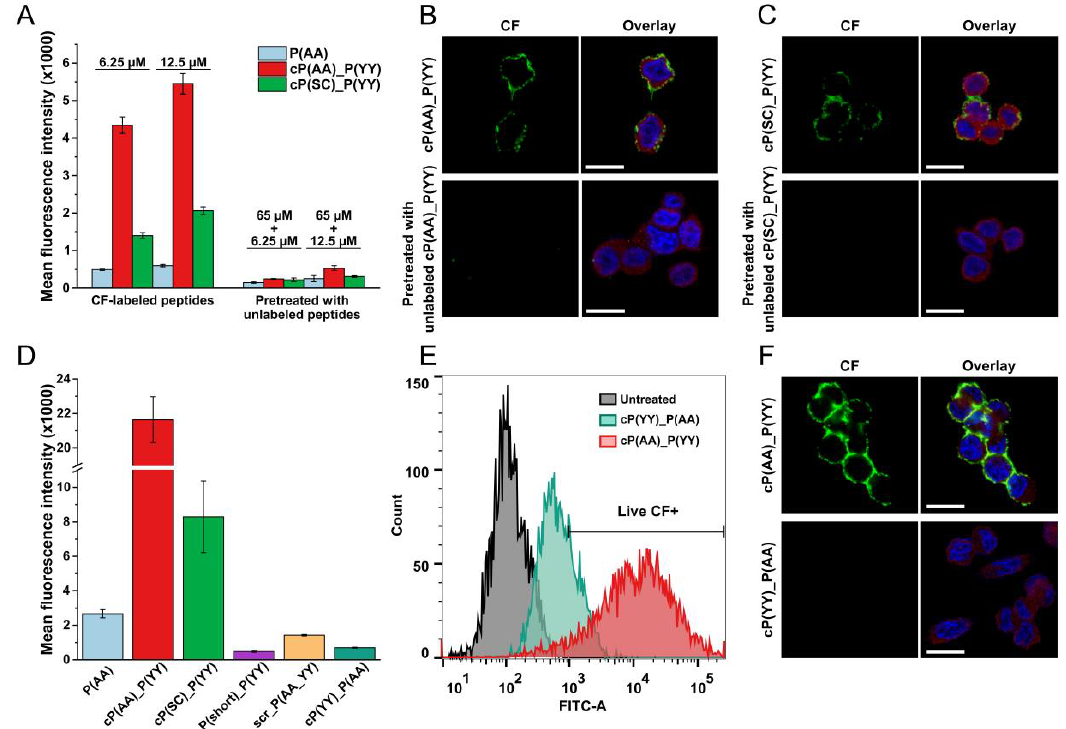
Figure 6. Specificity study of HER2-binding compounds. ( A ) MDA-MB-453 cells were preincubated with unlabeled peptides, and fluorescence was measured by flow cytometry. ( B , C ) Confocal microscopic imaging of conjugates cP(AA)_P(YY) and cP(SC)_P(YY), respectively, which were pretreated with unlabeled peptides. ( D , E ) Analysis of the reversed combined peptide (cP(YY)_P(AA)) by flow cytometry. ( F ) Imaging of the reversed combined peptide by confocal microscopy. The CF signal and the nucleus staining are represented by green and blue, respectively. HER2 was detected with an anti-HER2 antibody and a TRITC-conjugated secondary antibody, as shown in red. A Zeiss LSM 710 system was used for image acquisition. Scale bars represent 20 µm.